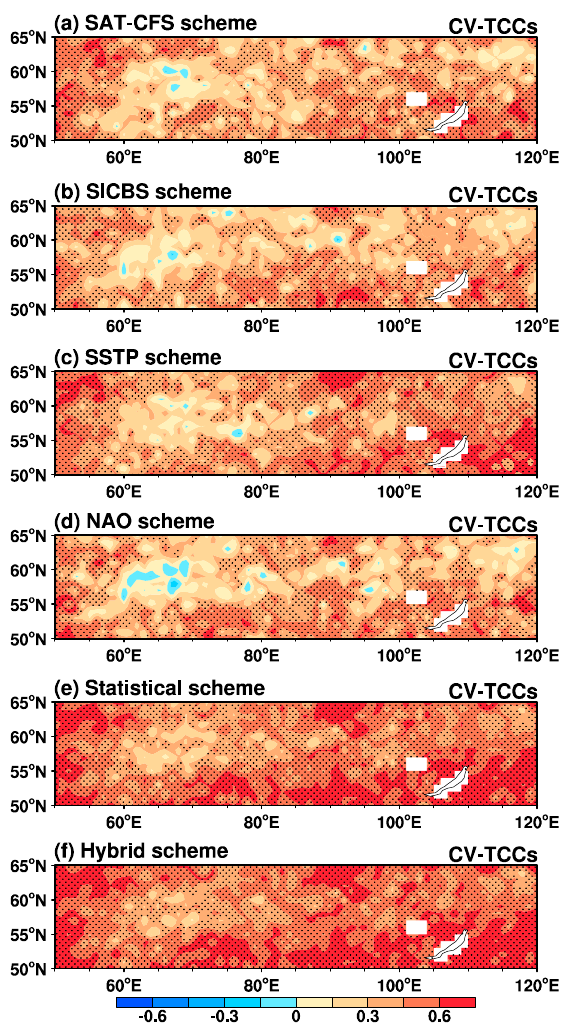
Figure 7. The temporal correlation coefficients (TCCs) between the spring (April–May–June (AMJ)) NDVI3g data and the cross-validation hindcast results of the ( a ) surface air temperature (SAT-CFS) scheme, ( b ) sea-ice cover (SIC) scheme, ( c ) sea surface temperature (SSTP) scheme, ( d ) North Atlantic Oscillation (NAO) scheme, ( e ) statistical scheme and ( f ) hybrid scheme during 1983–2015. Dotted regions are significant ( α = 0.05; t -test).